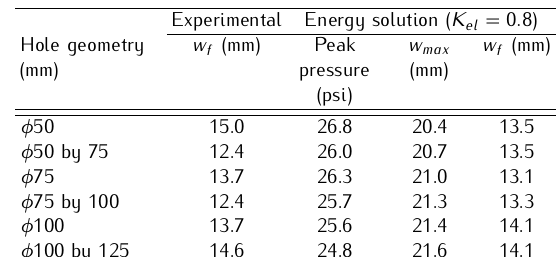
Table 4. Results of predicted maximum and final deflections for plates at centre of plate loaded to nominally 25 psi by energy method.